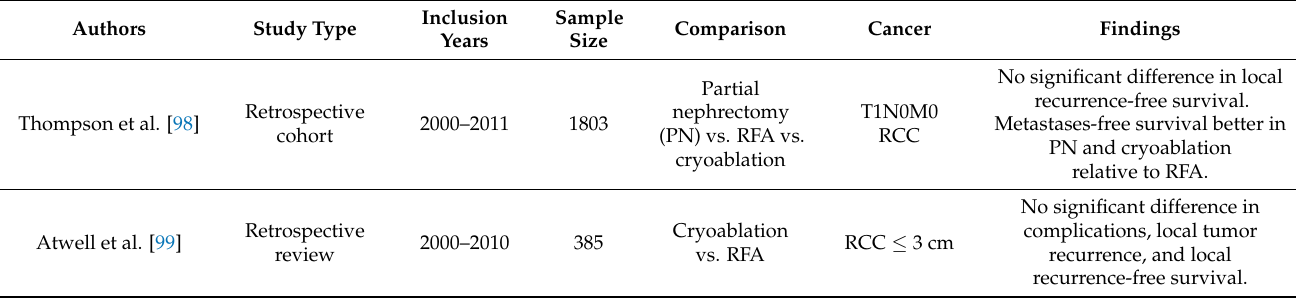
Figure 10. Cryoablation of left renal mass. A 57-year-old male with hematuria and left flank pain was found to have a left renal enhancing lesion (white arrow) on MRI images ( A ). ( B ) CT-guided percutaneous core needle biopsy found the 2.0 × 1.8 cm right renal lesion to be medullary fibroma while the 2.1 × 2.2 cm left renal lesion was International Society of Urologic Pathologists (ISUP)/World Health Organization (WHO) grade 2 RCC. The patient underwent cryoablation of the left mass. ( C ) One-month follow-up MRI showed complete tumor response. ( D ) Six-month follow-up MRI showed lesion shrinkage without residual tumor. Table 3. Comparison of ablation modalities for renal tumors.